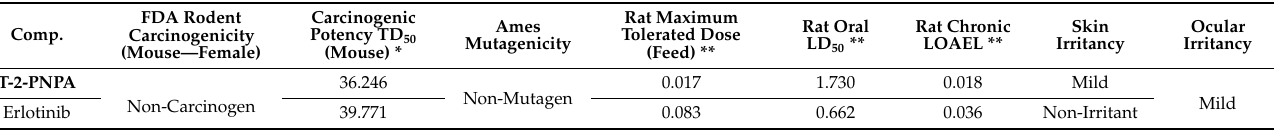
Table 4. In silico toxicity studies of T-2-PNPA and erlotinib.